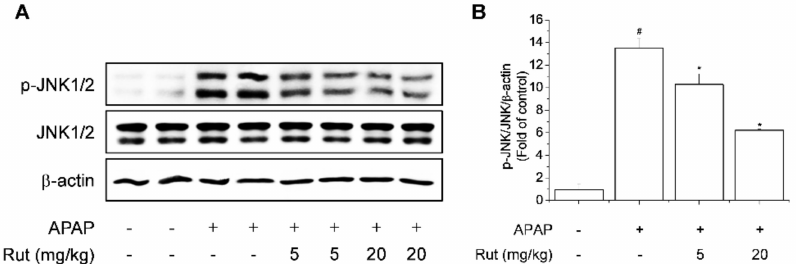
Figure 6. Protective effect of Rut on APAP-induced JNK1/2 activation in mice. Hepatic protein levels of phospho-JNK1/2 and JNK1/2 ( A ) were determined by western blotting. Protein level was analyzed using ImageJ software. Relative expression of the target protein was compared using β -actin as a control ( B ). Results are indicated as means ± SD ( n = 10). # Significantly different from the control ( p < 0.05). * Significantly different from the APAP-treated group ( p <